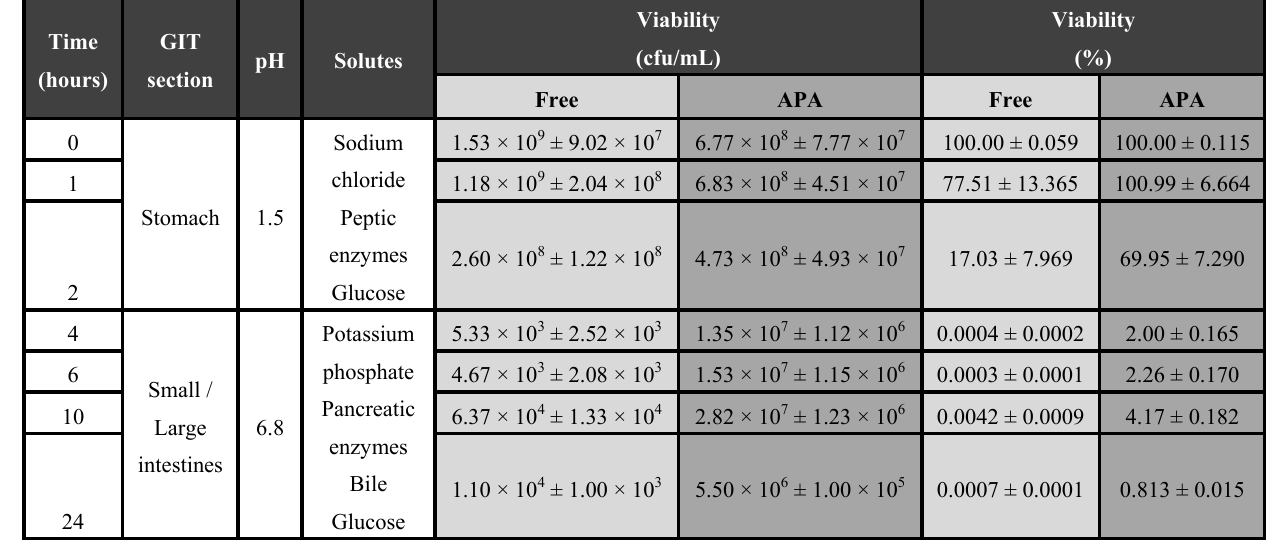
Table 1 . The viability of L. fermentum NCIMB 5221, through the in vitro GI passage and the associated conditions of the gastric and intestinal exposure. Free = free L. fermentum represent the mean of triplicates ± SD. These results demonstrate a significant difference in viability between the free and microencapsulated cells ( p < 0.001; Tukey’s